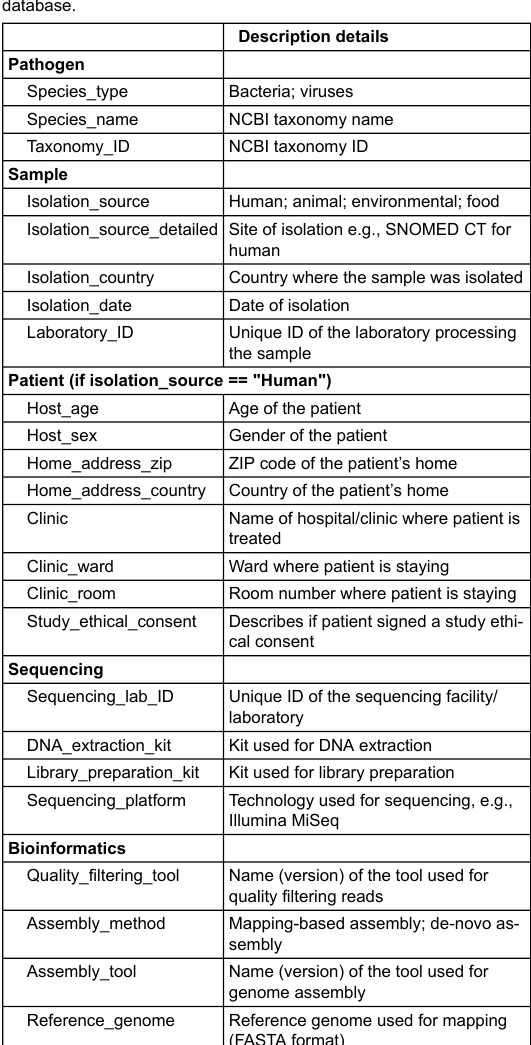
Table 1: Important minimum interoperable metadata for a surveillance